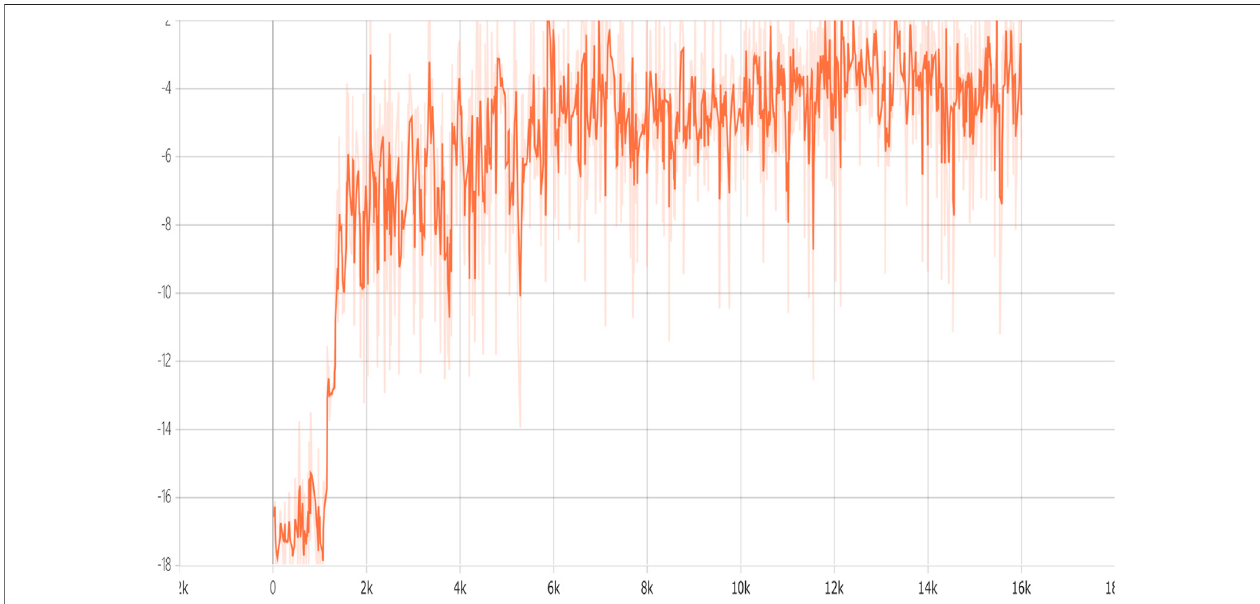
FIGURE 9 | Accumulated reward versus training episodes of CERACU.